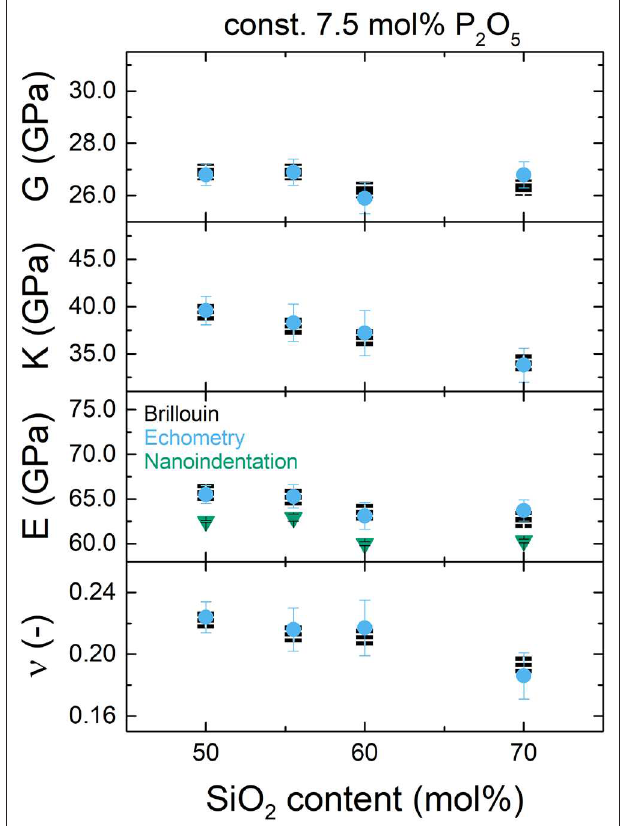
FIGURE 7 | Elastic properties obtained by Brillouin spectroscopy (black squares), ultrasonic echometry (blue circles) and nanoindentation (green triangles, only E) for glasses with 7.5 mol% P 2 O 5 and varying silica content: (from top to bottom) shear modulus (G), bulk modulus (K), Young’s modulus (E) and Poisson’s ratio ( ν ).